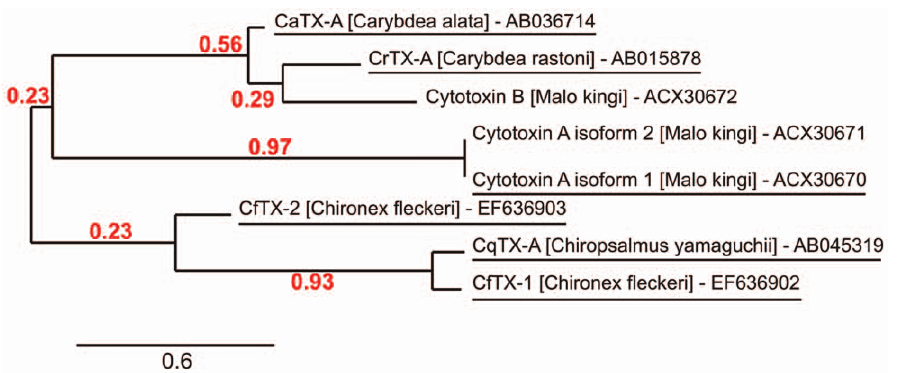
Figure 4. Phylogenetic tree of Cubozoan toxin proteins. Phylogenetic tree depicting the grouping of box jellyfish toxins found in GenBank into three broad classes. Proteins identified in this study are underlined and their GenBank accession number is indicated. The tree was produced using MUSCLE and PhyML for tree building and the aLRT statistical test [50] was used for branch support.